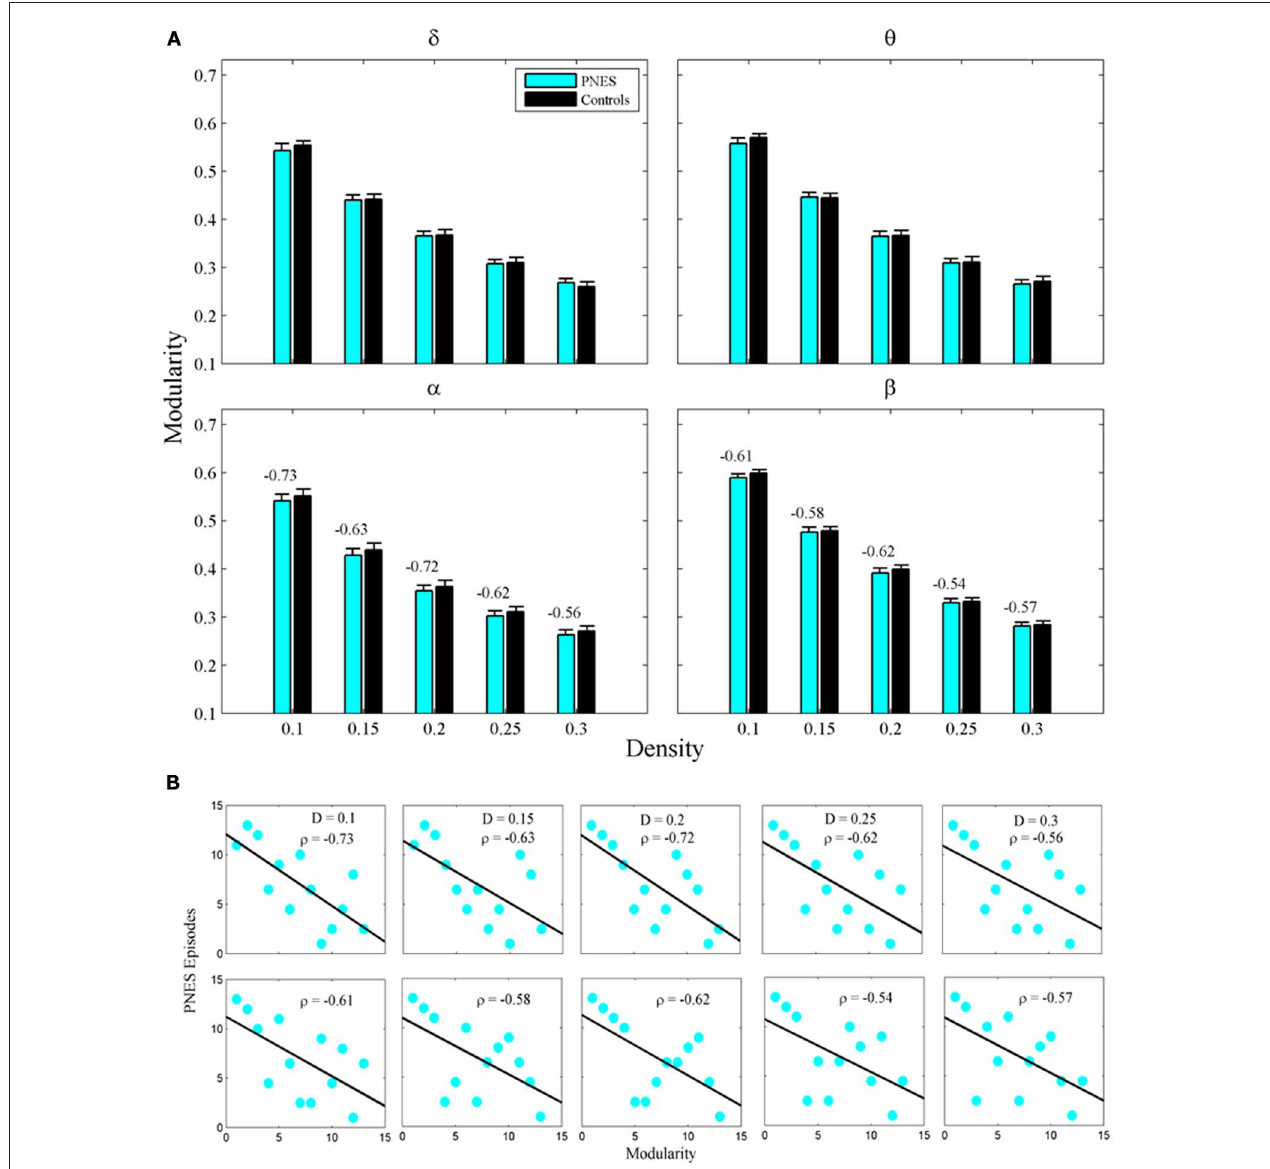
FIGURE 3 | Modularity index as a function of network density for PNES patients and controls. (A) The plots show the modularity of functional brain networks as a function of density in PNES patients and